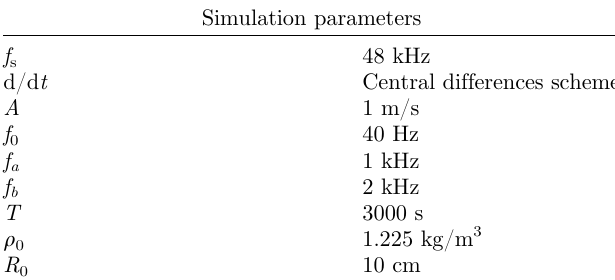
Table 1. Simulation parameters used for the Doppler distortion